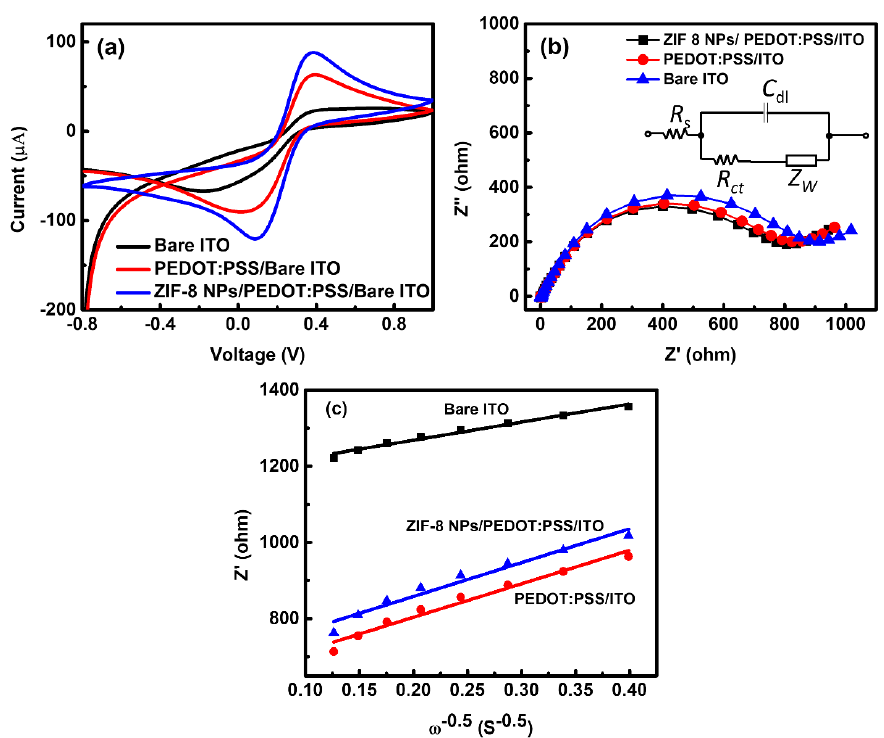
Figure 5. ( a ) CV characterization of the modification steps of ZIF-8 NPs/PEDOT:PSS/ITO elec- trode in PBS 7.4 containing 1 mM [Fe(CN) 6 ] 3 − /4 − and 0.1 M KCl at a scan rate of 50 mV/S and ( b ) EIS characterization of the modification steps of ZIF-8 NPs/PEDOT:PSS/ITO electrode in PBS 7.4 containing 1 mM [Fe(CN) 6 ] 3 − /4 − and 0.1 M KCl. The inset shows the equivalent Randle’s circuit. ( c ) Z’ vs. ω − 0.5 plot obtained from Figure 5b for bare ITO, PEDOT:PSS/ITO, and ZIF-8 NPs/PEDOT:PSS/ITO electrodes.